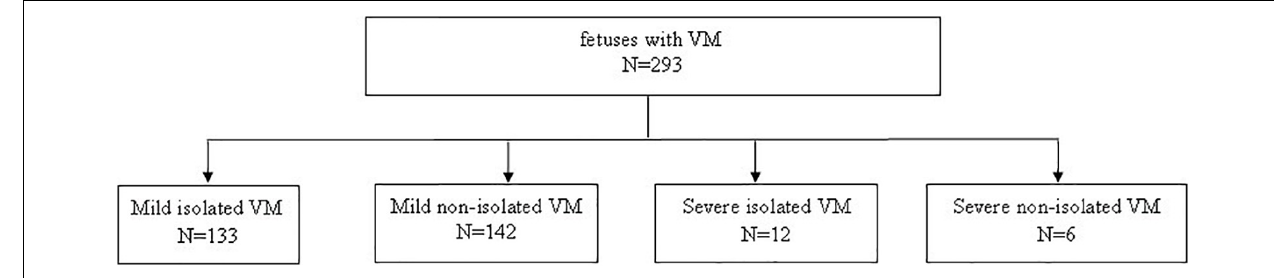
FIGURE 1 | Enrollment of fetuses.